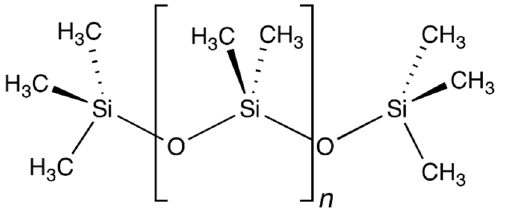
Figure 4. Chemical formula of polydimethylsiloxane (PDMS) [44].